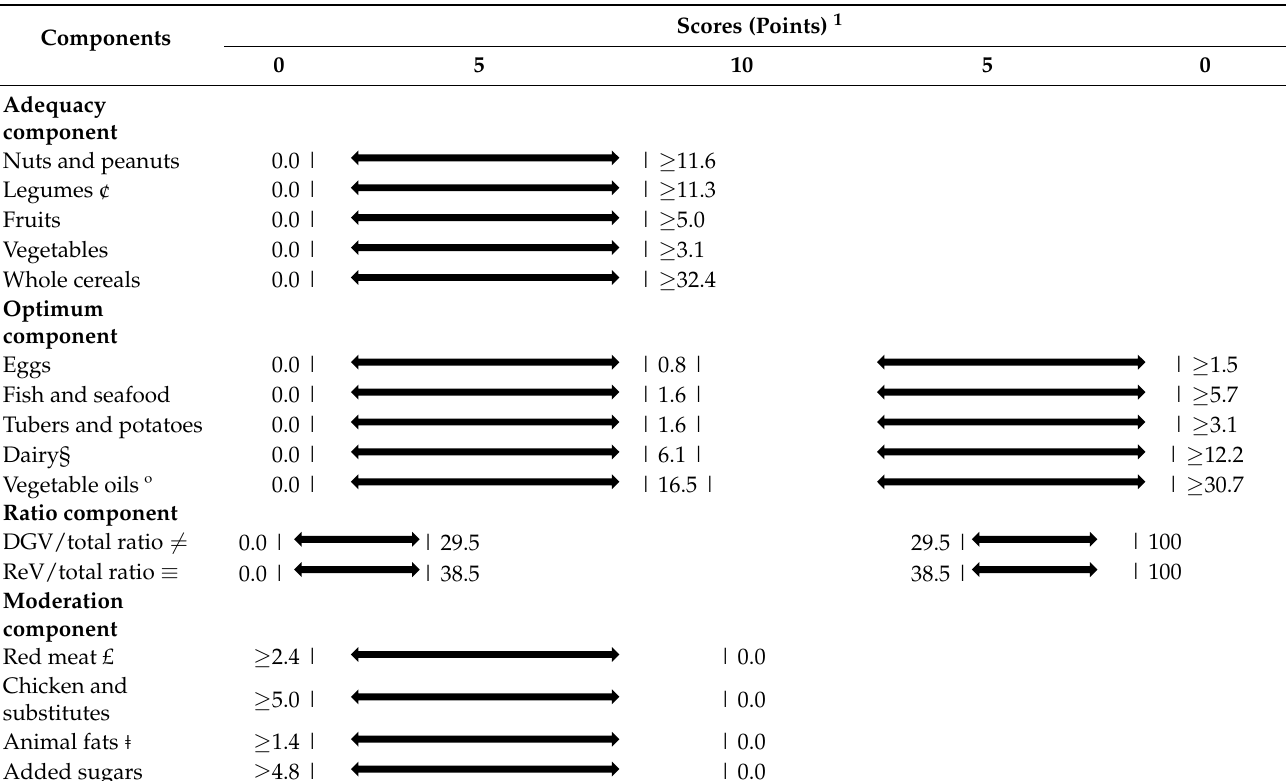
1 All values expressed as caloric densities from the reference diet proposed by the EAT-Lancet Commission. The bars represent the limits. £ Red meat: beef, lamb, and pork. ¢ Legumes: beans and soy. § Dairy: excluding dairy fats. º Unsaturated oils: including palm oil. ≠ DGV/total ratio: ratio between the energy intake of dark green vegetables (numerator) and the total of vegetables (denominator) multiplied by 10. ≡ ReV/total ratio: ratio between the energy intake of red and orange vegetables (numerator) and the total of vegetables (denominator) multiplied by 10. ǂ Animal fat: lard, tallow, and dairy fats. DGV/total ratio: dark green vegetable/total ratio. ReV/total ratio: red vegetable/total ratio.